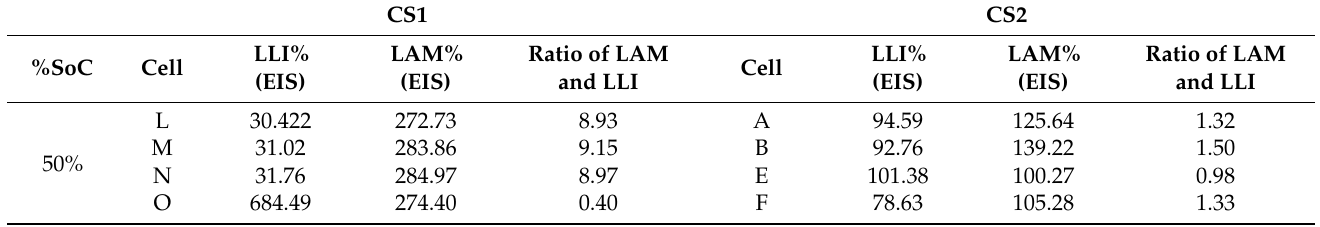
Table 7. EIS data of the cells for the same DM group. Table 8. EIS data of the cells for different DM groups.